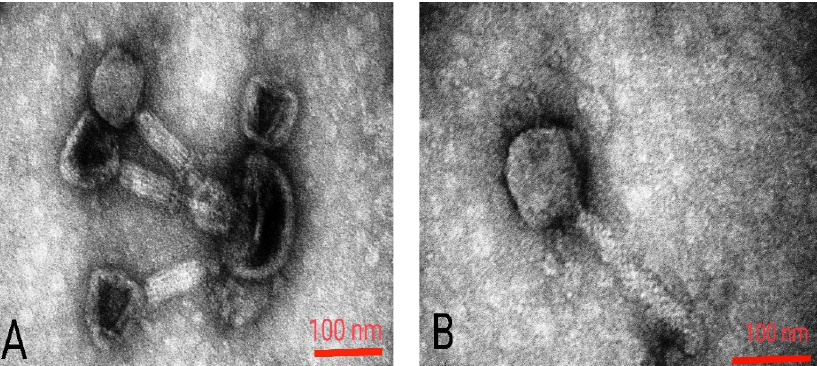
Figure 2. Morphology of phage particles under transmission electron microscope. Phage PB10 ( A ) and PA19 ( B ). The scale bars represent 100 nm.